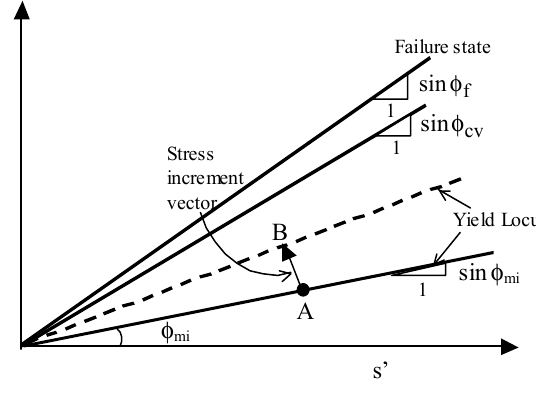
Figure 1. Yield locus of the UBCSAND2 model.